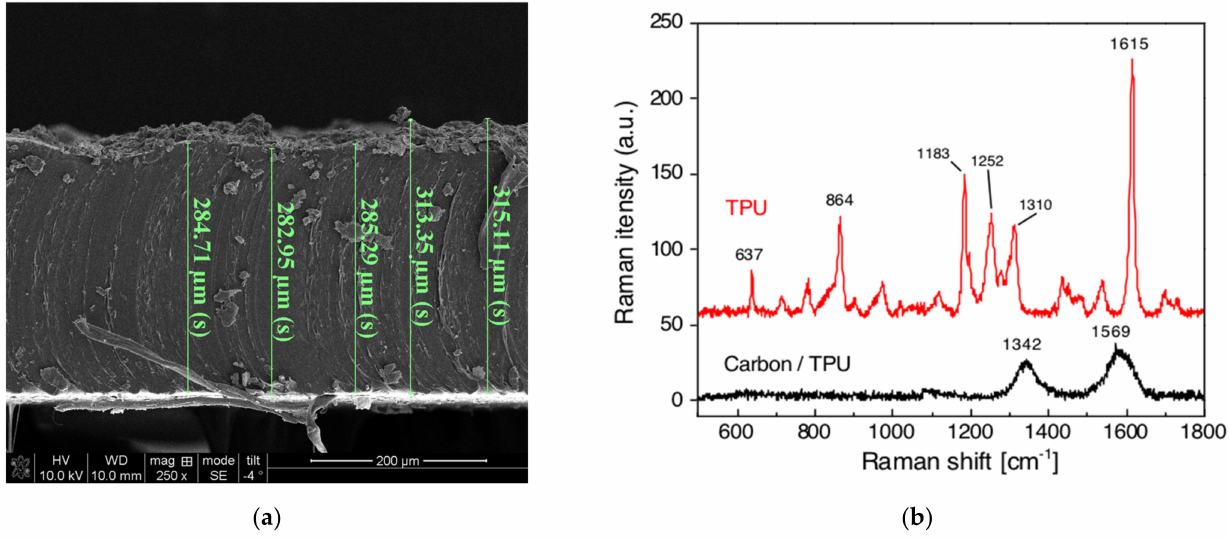
Figure 5. ( a ) A scanning electron micrograph of the nanocomposite paint cross-section was obtained to estimate its thickness and uniformity. ( b ) Raman spectra of the nanocomposite paint (in black), as well as the TPU substrate (in red), are